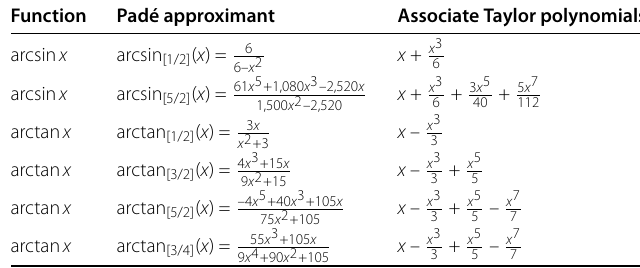
Table 1 Padé approximants for arcsin x and arctan x Function Padé